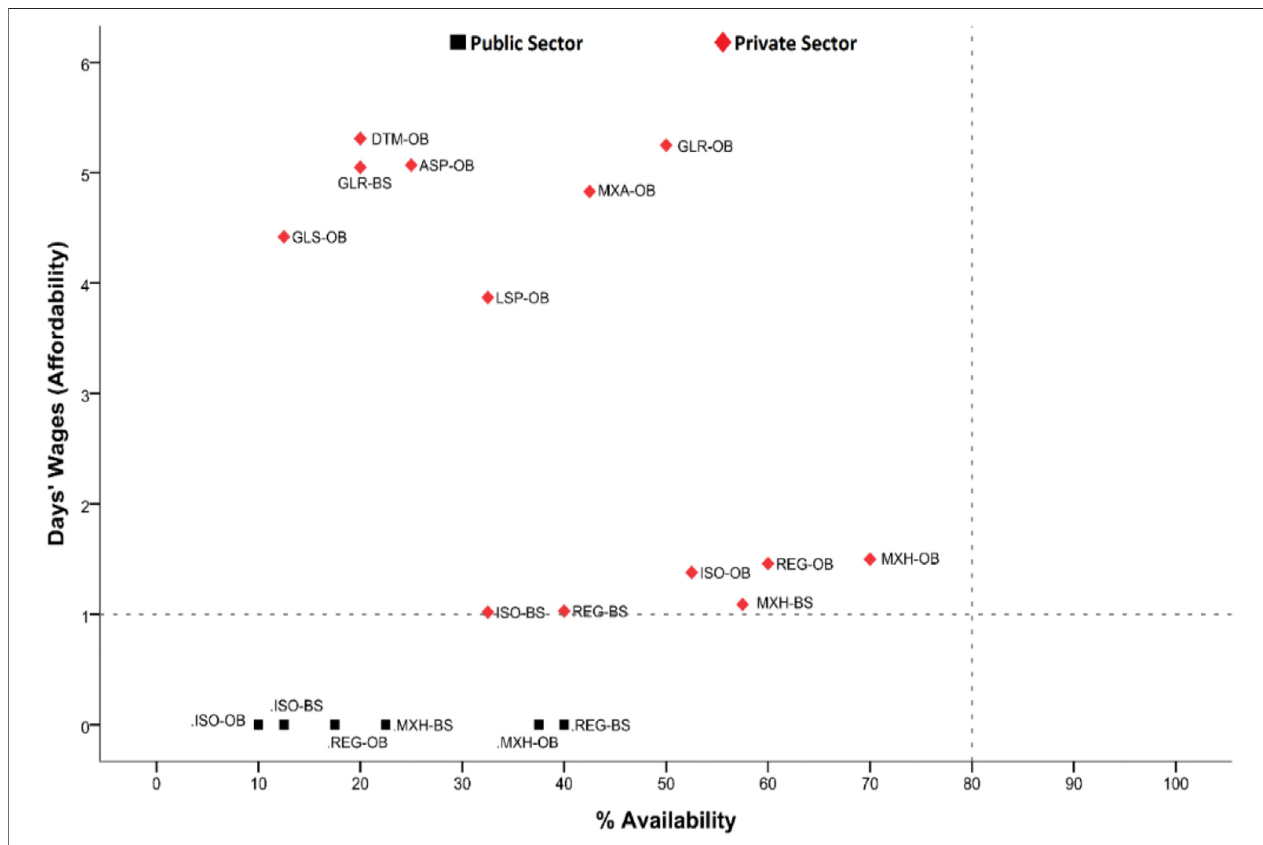
FIGURE2| Comparativeanalysisofinsulinavailabilityandaffordability.REG-OB,regularhumaninsulinoriginatorbrand;REG-BS,regular humaninsulinbiosimilar; ISO-OB, isophane human insulin originator brand; ISO-BS, isophane human insulin biosimilar; MXH-OB, Mixed 70/30 human insulin originator brand; MXH-BS, Mixed 70/30humaninsulinbiosimilar;ASP-OB,aspartanaloginsulinoriginatorbrand;GLS-OB,glulisineanaloginsulinoriginatorbrand;LSP-OB,lisproanaloginsulinoriginator brand; DTM-OB, detemir analog insulin originator brand; GLR-OB, glargine analog insulin originator brand; GLR-BS, glargine analog insulin biosimilar; MXA-OB, mixed analog insulin originator brand.